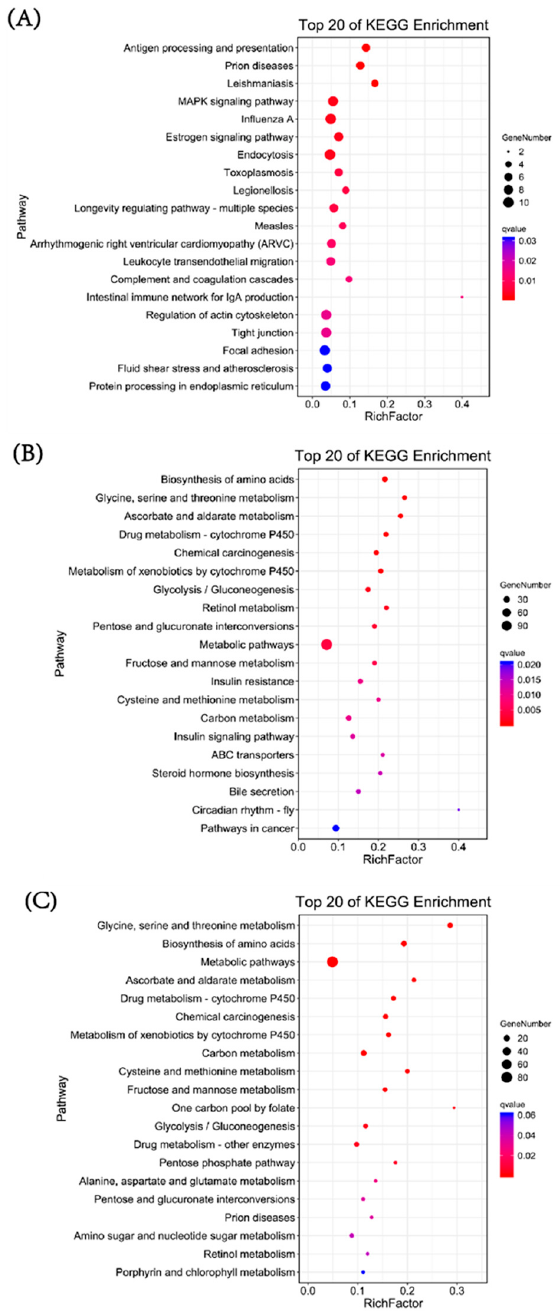
Figure 3. KEGG pathway enrichment analysis of DEGs in pairwise comparisons between three time points. ( A ) Enriched KEGG pathways from the 6 hpi vs. 0 hpi comparison. ( B ) Enriched KEGG pathways from the 12 hpi vs. 0 hpi comparison. ( C ) Enriched KEGG pathways from the 12 hpi vs. 6 hpi